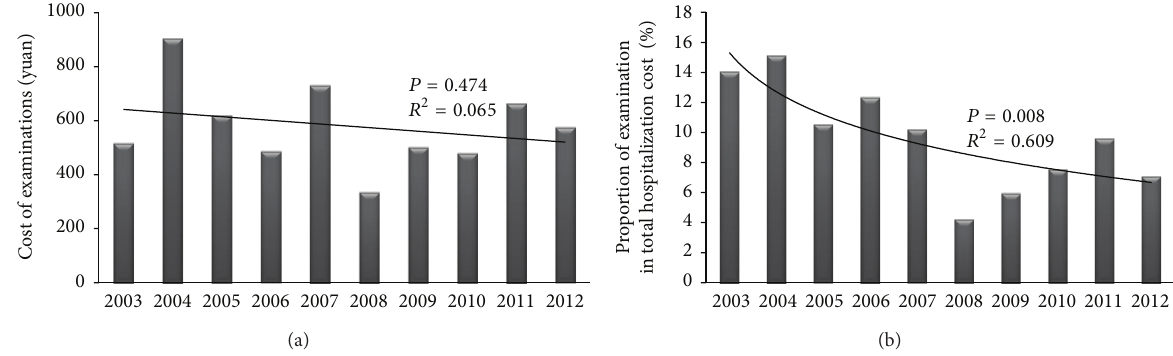
Figure 5: Cost of examinations. (a) Cost of examinations; (b) the proportion of examination in total hospitalization cost.